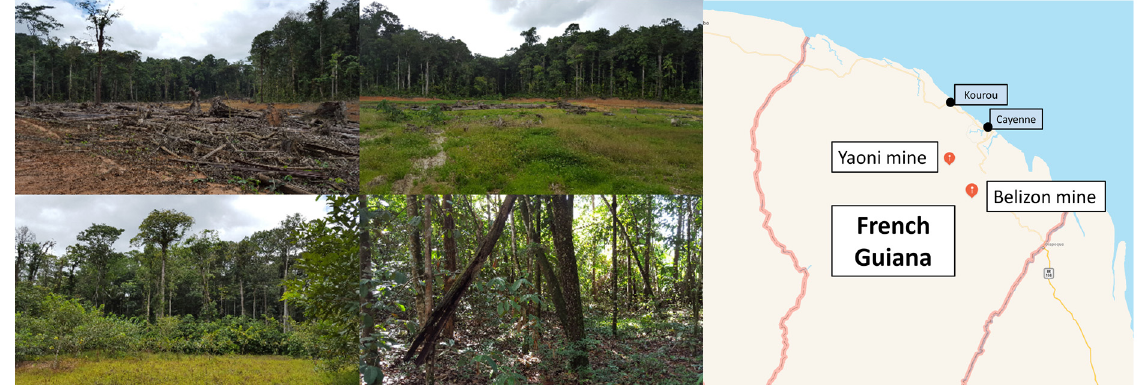
Figure 1. Illustration of some examples of different stages of ecological restoration on formers Guyanese gold mining sites and geographical location of the Yaoni and Belizon mines in French Guiana. Non-restored site ( top left ), ecological restoration with herbaceous species after 3 years (( top right ), Bel1), ecological restoration with fabaceous species after 3 years (( bottom left ), Bel3), ecological restoration with fabaceous species after 18 years (( bottom right ), Yao3). The pictures were taken during a second sampling campaign in April 2016 on sites undergoing ecological restoration.